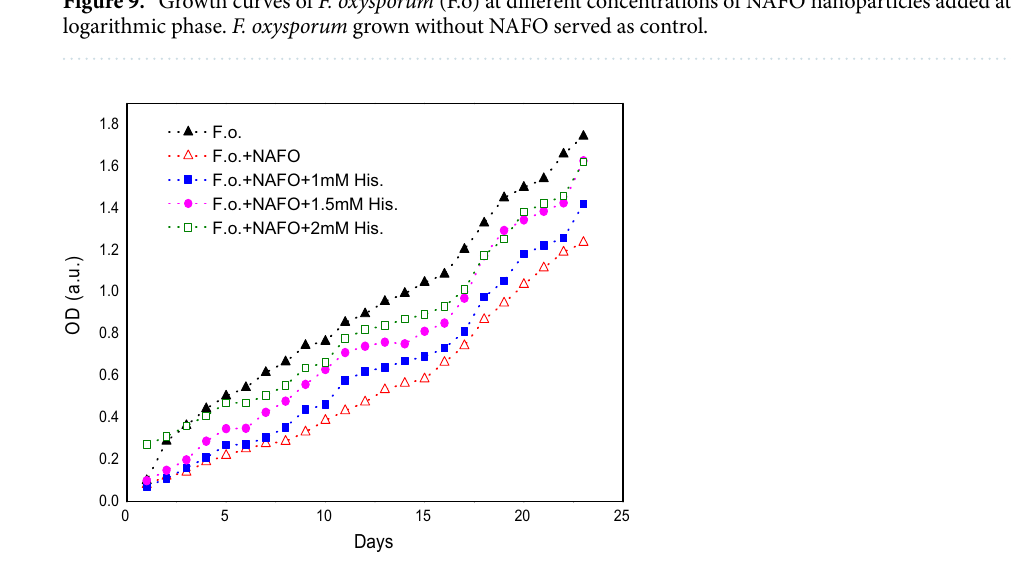
Figure 10. Effect of histidine on the growth curve of F. oxysporum with NAFO (500